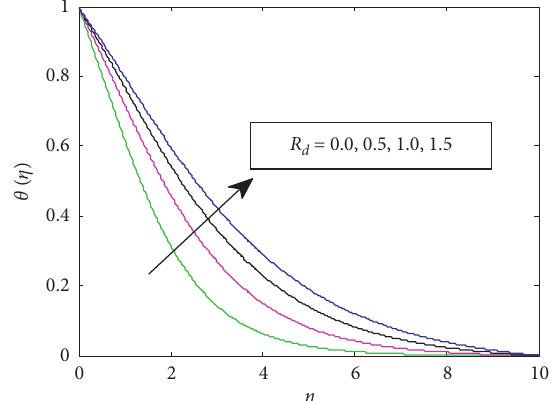
Figure 3: Temperature distribution for different values of radiation parameter.